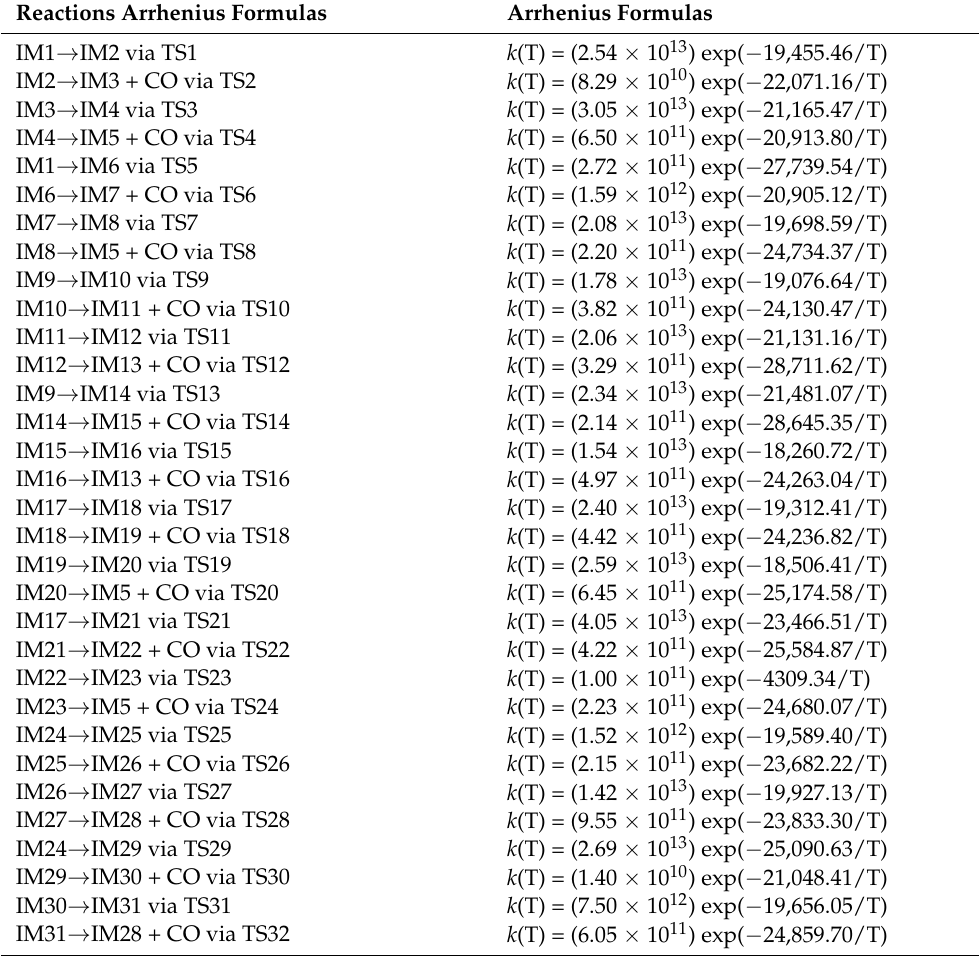
Table 1. Arrhenius formulas for chloro-bicyclopentadienyls formation routes from the cross- condensation reactions of PhR with 2-CPR and 3-CPR over the temperature range of 600~1200 K. (Units are s − 1 and cm 3 molecule − 1 s − 1 for unimolecular and bimolecular reactions, respectively). Reactions Arrhenius